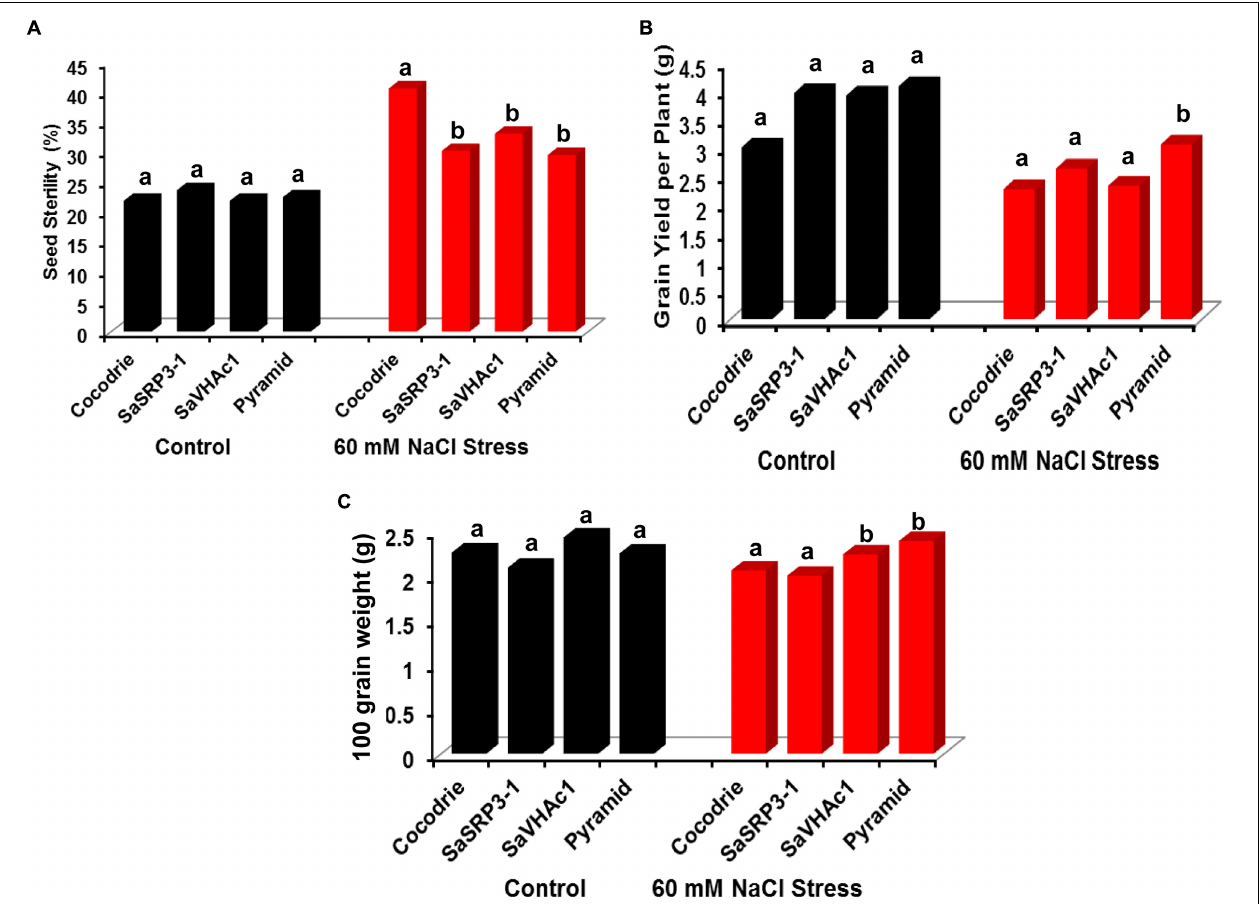
FIGURE 7 | Analysis of yield parameters in transgenic and control plants under salt stress at the reproductive stage in greenhouse. (A) Impact of salt stress on grain filling and seed sterility; (B) comparison of grain yield per plant under salt stress; (C) variation in 100-grain weight due to salt stress. Different letters on bar diagram indicate the statistical significance at 5% level based on Dunnett’s